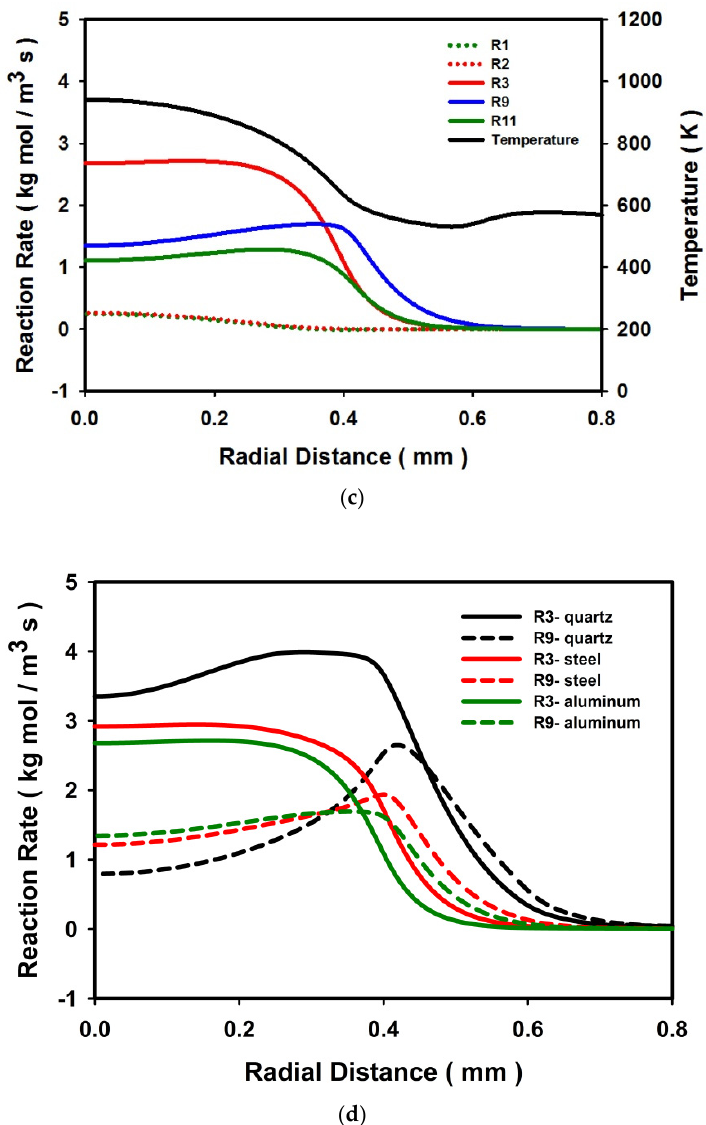
Figure 10. Radial profiles of static temperature along with net rate of selected reactions for ( a ) quartz, v = 0.13 m/s, ( b ) steel, v = 0.14 m/s and ( c ) aluminum, v = 0.14 m/s, ( d ) cross comparison of R3, R9 for quartz, steel, and aluminum.